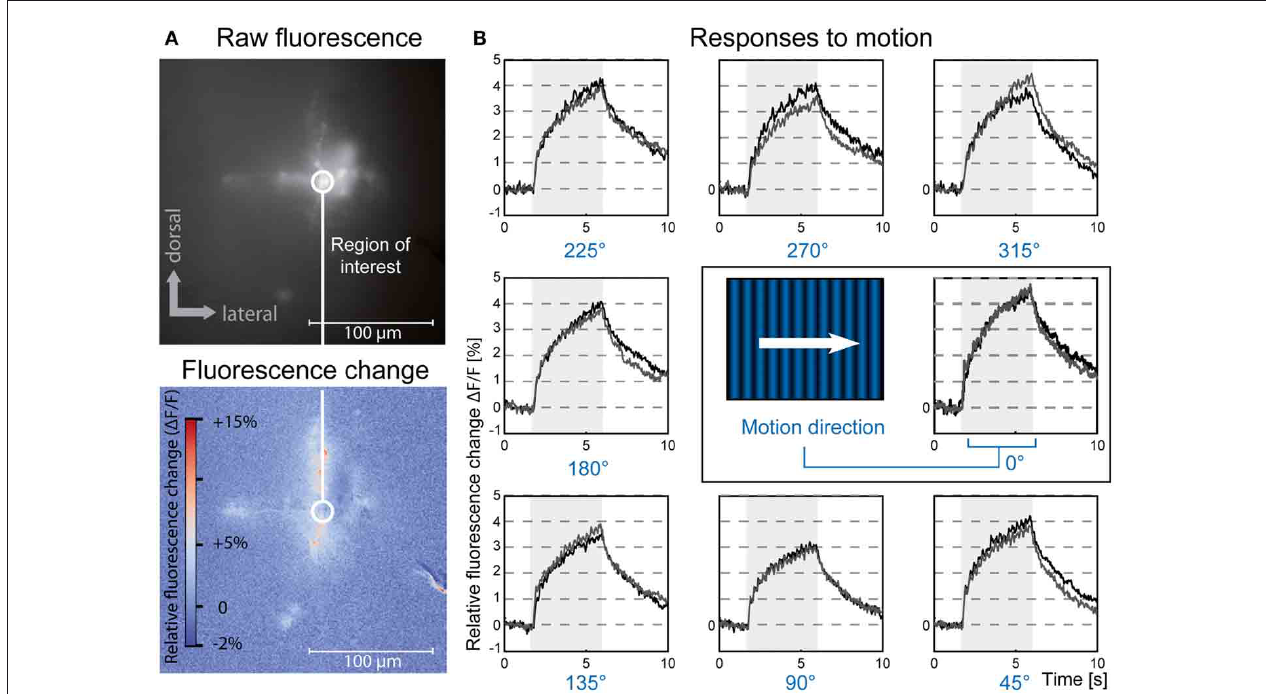
branch-like structure visible in the bottom right is an artifact caused by movement of a superficial trachea. (B) Relative fluorescence changes ( (cid:3) F / F ) in the region of interest indicated in (A) in response to a grating drifting in eight directions, two repetitions (gray and black traces). Gray rectangles indicate duration of stimulus movement. Stimuli were presented on a 60Hz TFT screen. The data presented here is the same as used for Figure 4A .